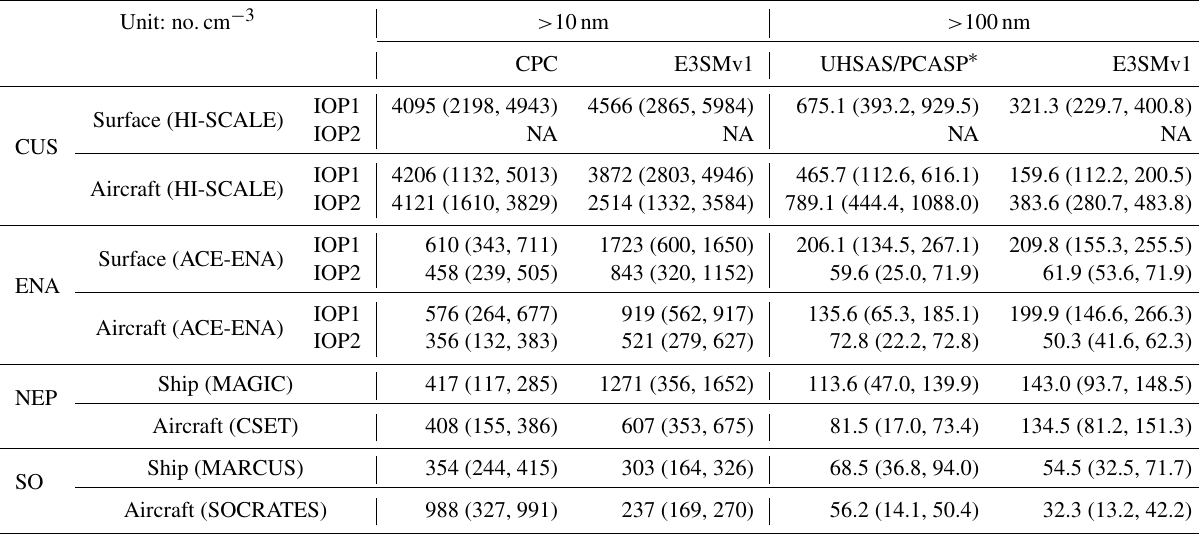
Table 3. Mean aerosol number concentration and interquartile range (25th and 75th percentiles, small numbers in parenthesis) for two size ranges averaged for each field campaign (or each IOP for HI-SCALE and ACE-ENA). Aircraft measurements 30min after takeoff and before landing are excluded to remove possible contamination from the